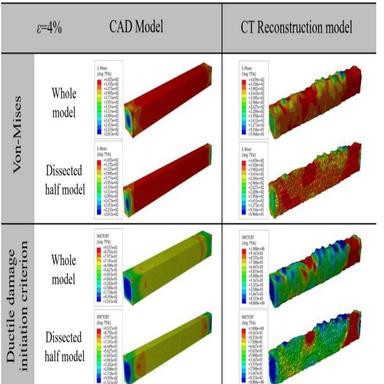
Numerical simulation results presented for single struts: FEA of CAD model (left), FEA of CT reconstructed model(right).